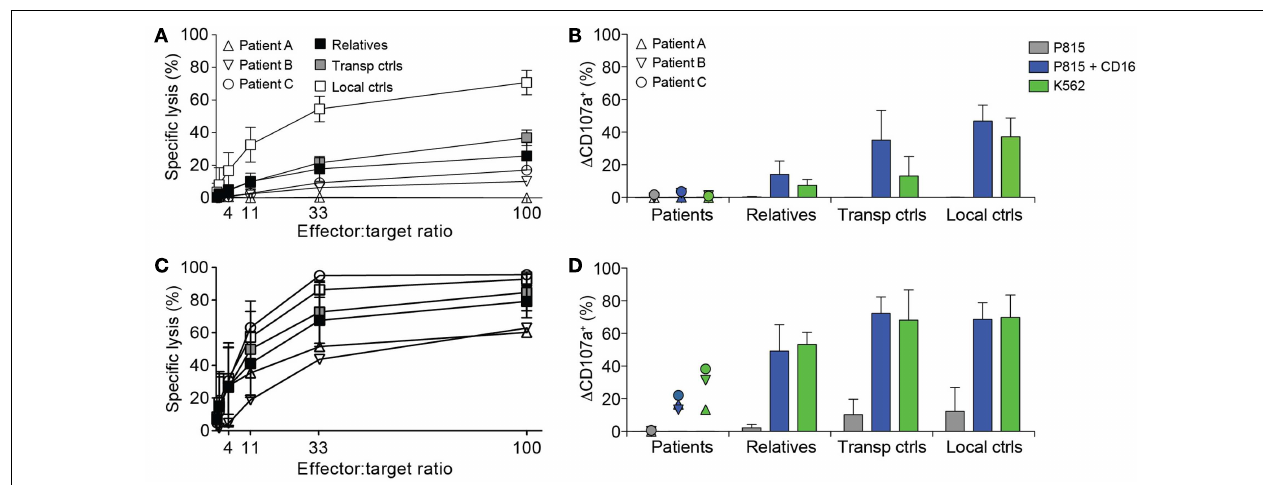
Symbols indicate individual values for patients or mean values for relatives and controls. Error bars indicate SD. PBMC (B) freshly isolated or (D) stimulated with IL-2 overnight were mixed with target cells and antibodies, as indicated.The cells were stained with antibodies to lineage markers and CD107a.The frequency of cells expressing surface CD107a was determined by flow cytometry. Symbols indicate values for patients and bars mean for relatives and controls. Error bars indicate SD.